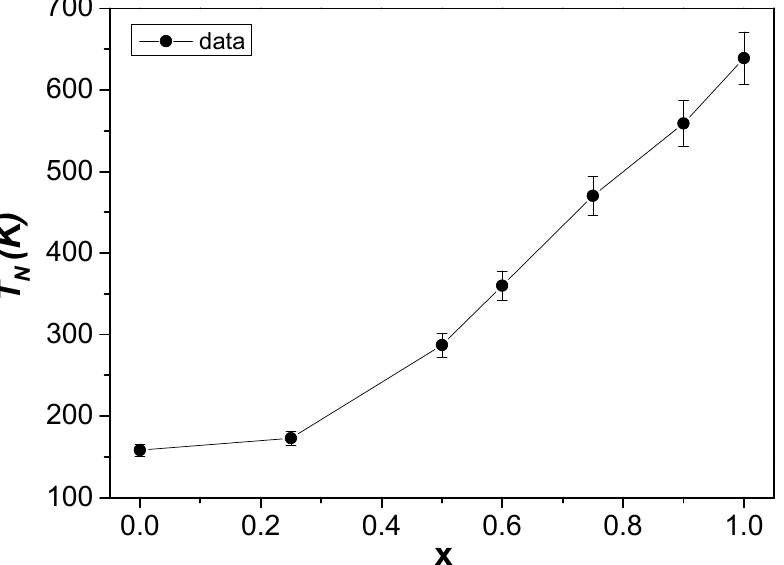
Figure 11. Néel temperature T N dependence on x (Fe concentration) estimated from 1000 Oe M(T) curves. The solid line passing by experimental points is only a guide for viewing.